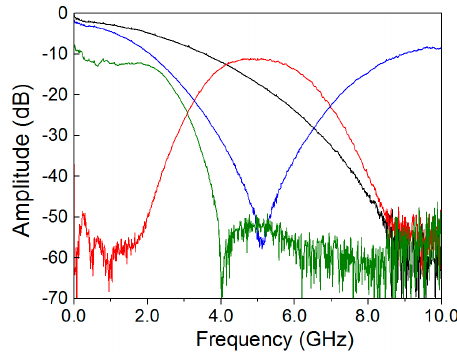
Figure 12. Measured RF equalization functions obtained by the multiband filter based RF equalizer.